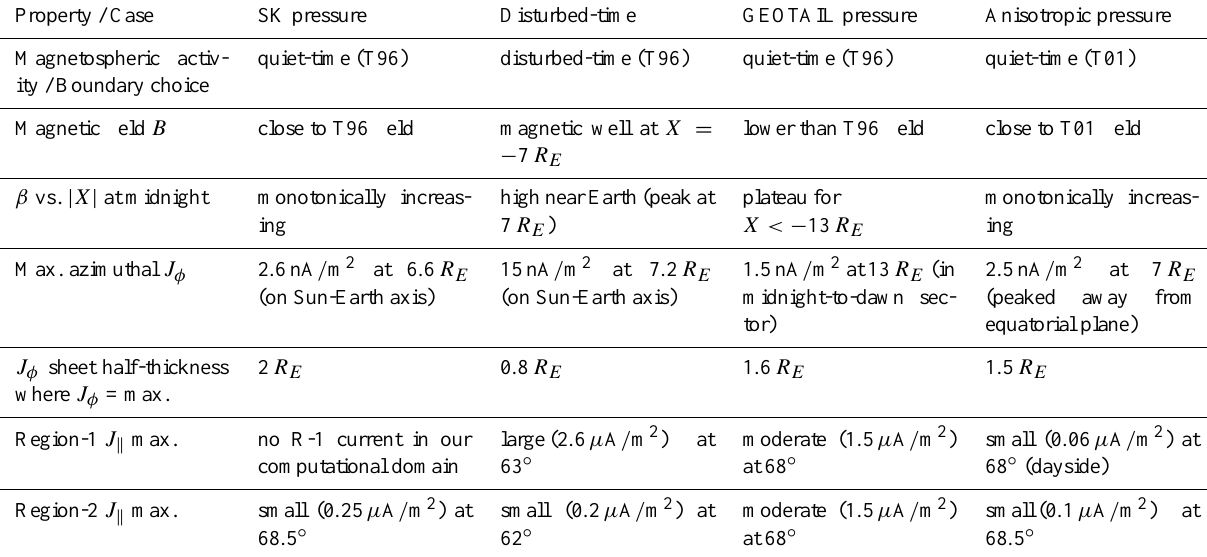
Table 1. Physical characteristics of the four computed 3-D equilibrium